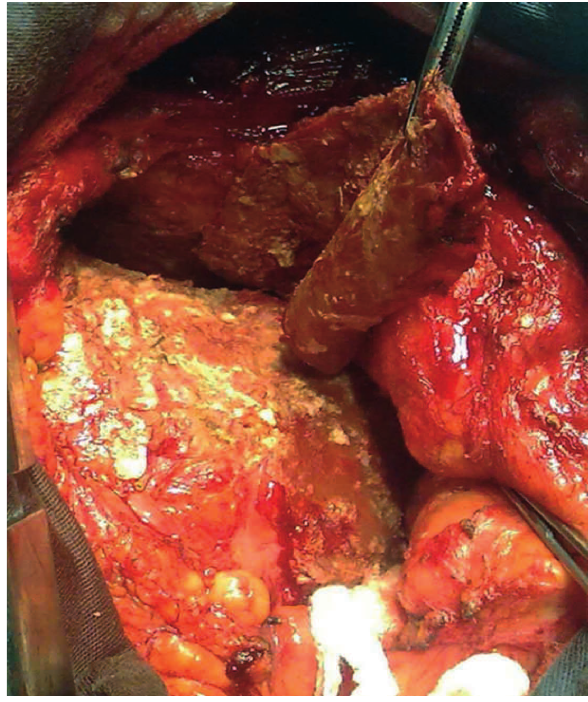
Fig. 3 – Esternotomia mediana, demonstrando as calcificações sobre as câmaras direitas e a parede espessada do cisto pericárdico. No reparo, a porção superior e lateral direita do cisto